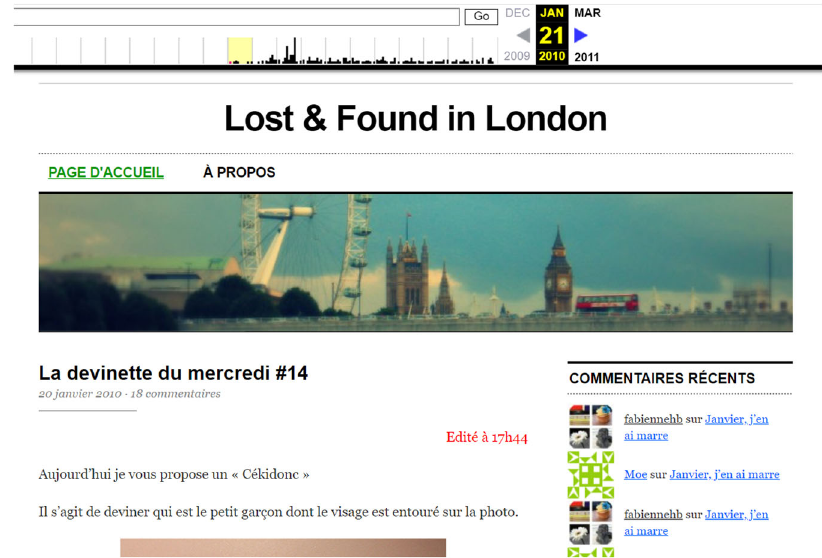
Fig. 1 Lost in London homepage, fi rst capture, archived on 21 January 2010. The original banner conforms to a stereotypical representation of London and the French language dominates. This fi gure is not covered by the Creative Commons Attribution 4.0 International License. Reproduced with permission of Fabienne Henry; copyright ©Fabienne Henry, all rights